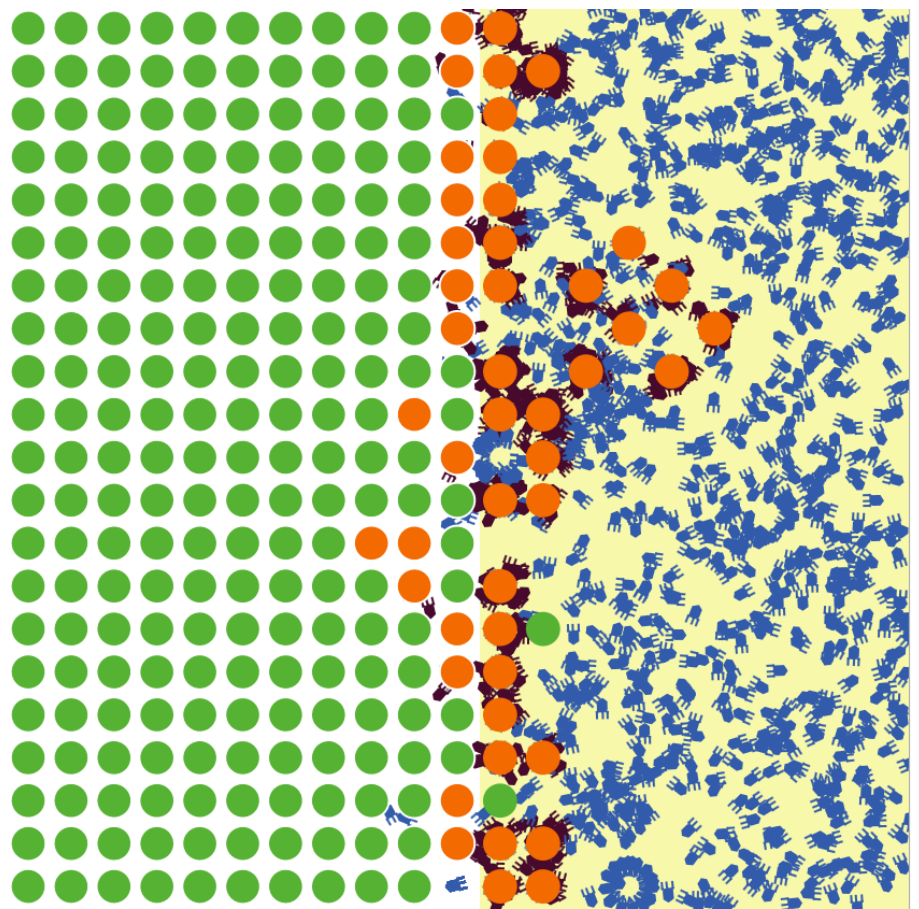
Figure 2. Illustration of self-organization of phages and cells with clumped EPS. White background indicates EPS, yellow is absence of EPS. A green (orange) circle is an uninfected (infected) cell. A blue or black legged icon is a phage (blue is free, black is attached to a cell). Phages are mostly confined to the EPS-free zone and the first row of EPS. Figure was generated from a NetLogo trial with a grid size of 21 × 21, a burst of 20, diffusion step size of 0.45 and attachment probabilities as in Figure 1C. There were 32 phage (partially obscured by cells) in the first three rows of EPS; α b for the entire grid was